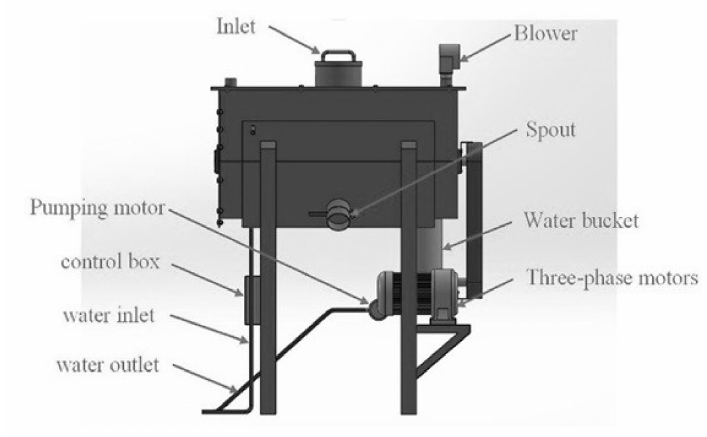
Figure 3. Fermentation barrel architecture diagram.